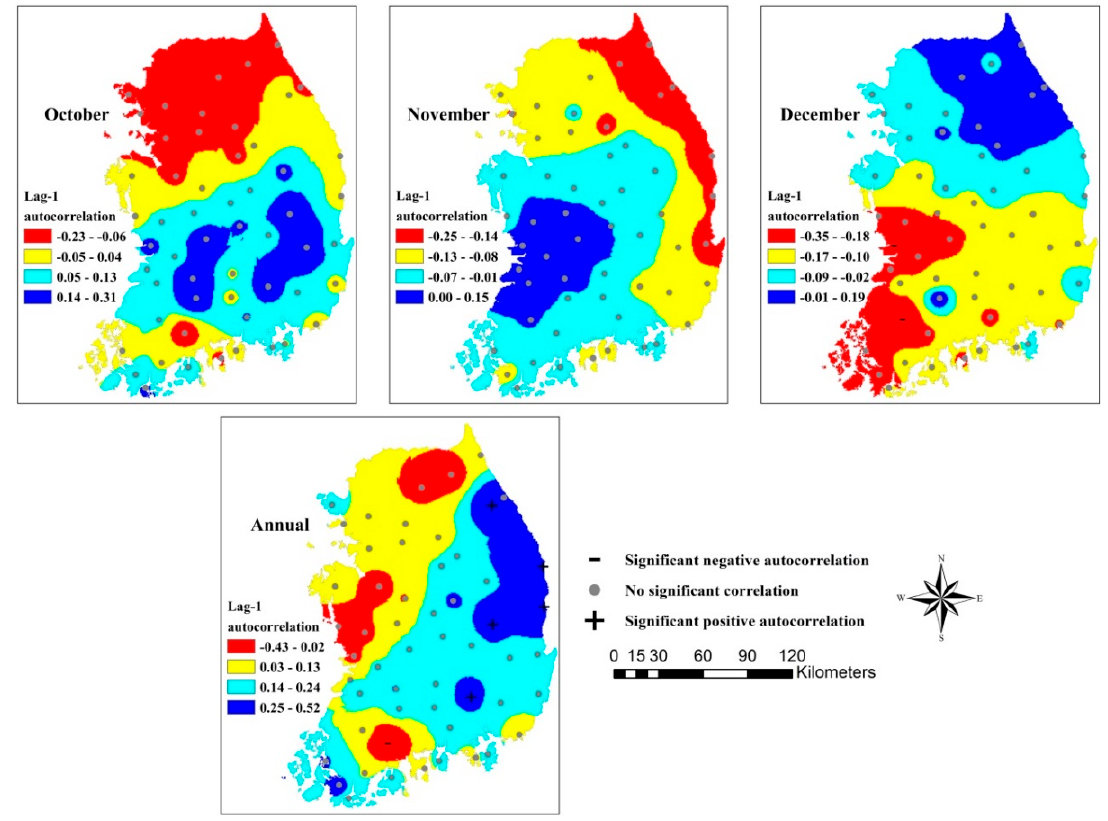
Figure 4. Maps showing the spatial patterns of lag-1 autocorrelation coefficient of monthly and annual precipitation across South Korea.